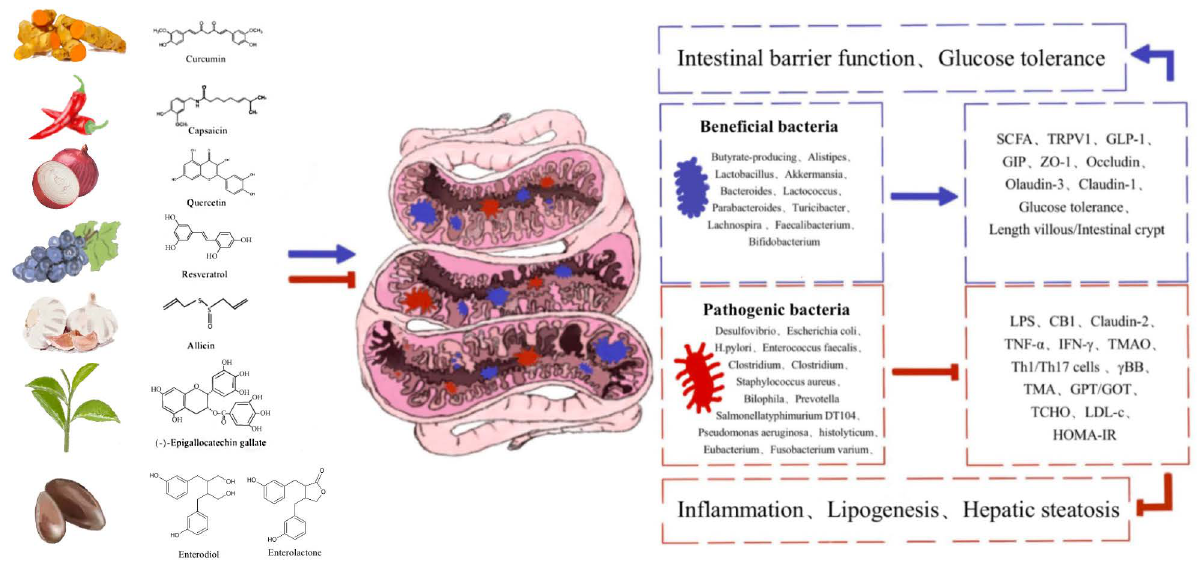
Figure 3. Plant-derived bioactive compounds improve host health by modulating the intestinal microbiota